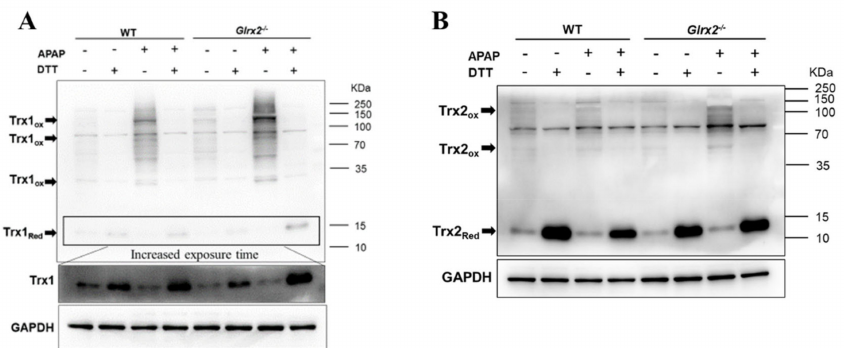
Figure 4. Glrx2 knockout enhanced Trx oxidation in liver exposed to APAP for 1 h. ( A , B ) Trx redox state in livers was detected by Western blot in the presence or absence of 50 mM dithiothreitol (DTT). n = 3, a representative one is shown. GAPDH as the loading control. Arrows point to the oxidized form of Trx1/2.